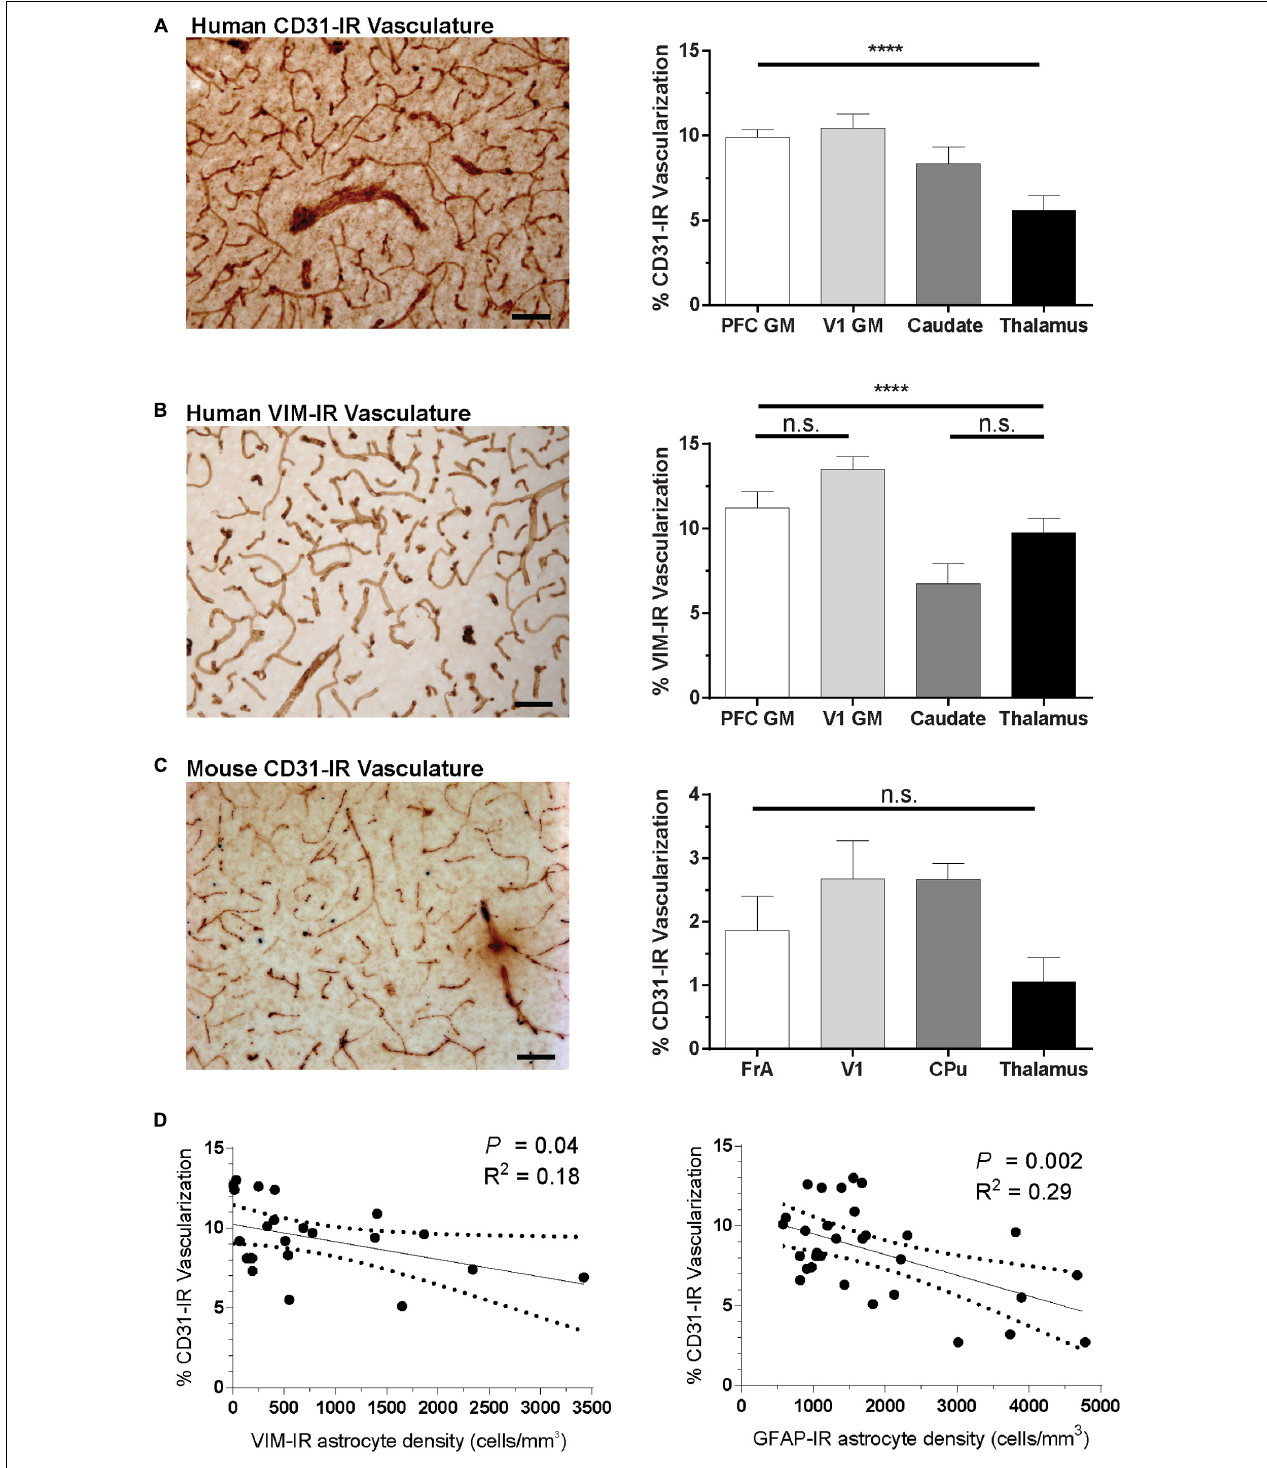
FIGURE 9 | Regional differences in vascularization correlate with regional differences in astrocyte density. (A,B) The area occupied by CD31-IR and VIM-IR blood vessels was significantly greater in cortical than in subcortical regions. (C) There were no significant differences in the area occupied by CD31-IR blood vessels between mouse brain regions, but this coverage was substantially lower that that measured in human samples (A,B) . (D) Human VIM-IR and GFAP-IR astrocyte density negatively correlated with CD31-IR vascularization across regions. One value from the caudate nucleus was excluded as an outlier for both regressions, and both the thalamus and cortical white matter values were excluded from the VIM-IR density regression as VIM-IR cells were mostly absent from these regions. Scale bars = 50 µ m. n.s. p > 0.05, **** p ≤ 0.0001 (Human: n = 8; Mouse: n = 5; Matched One-Way ANOVAs).